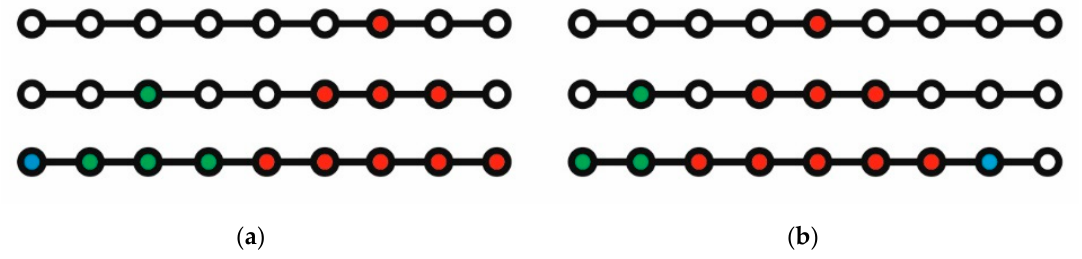
Figure 2. Time steps of the burning a path on nine nodes: ( a ) Ideal case; ( b ) Result of the Algorithm 1.